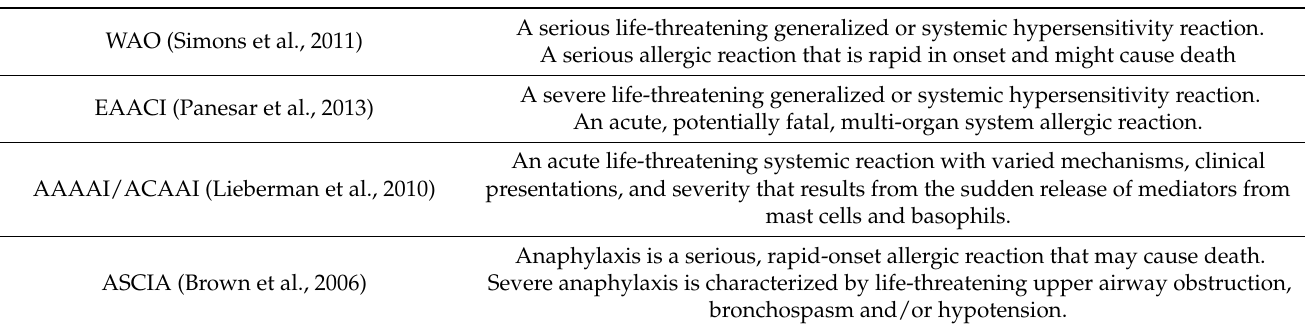
Table 1. Definitions of